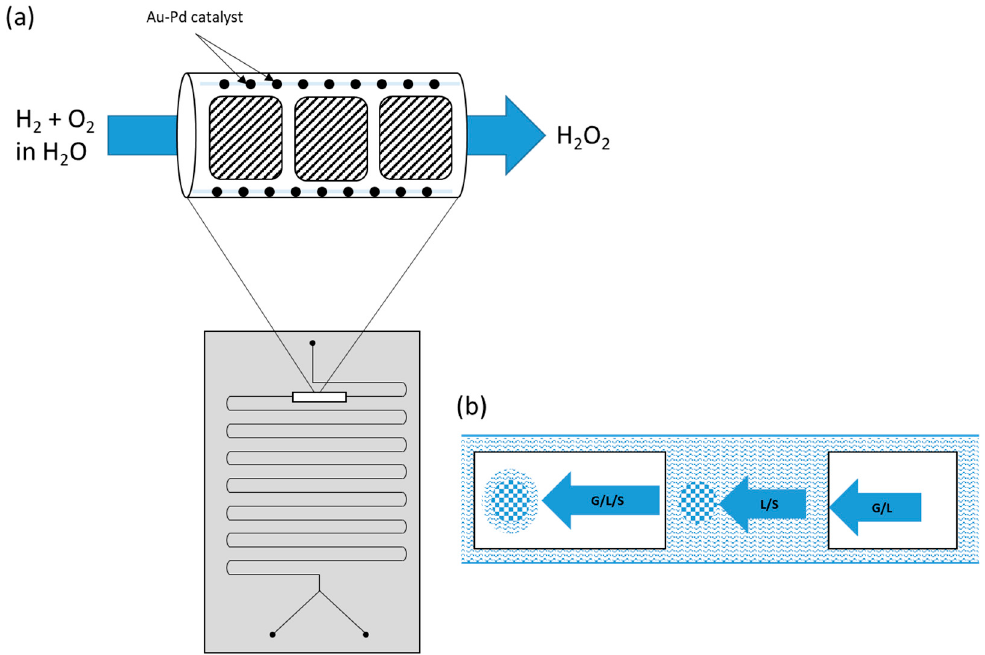
Figure 2. ( a ) A general microreactor design adapted by Kanungo et al. with a magnified view of the Au-Pd packing in the capillaries of the channel (scheme adopted from Kanungo et al. [72], https://pubs.acs.org/doi/abs/10.1021/acs.nanolett.7b03589). ( b ) Mass transfer scheme in a packed bed microreactor (G-gas, L-liquid, S-Solid) (scheme taken from Voloshin et al. [74], reprinted here with the kind permission of Elsevier publishing group).